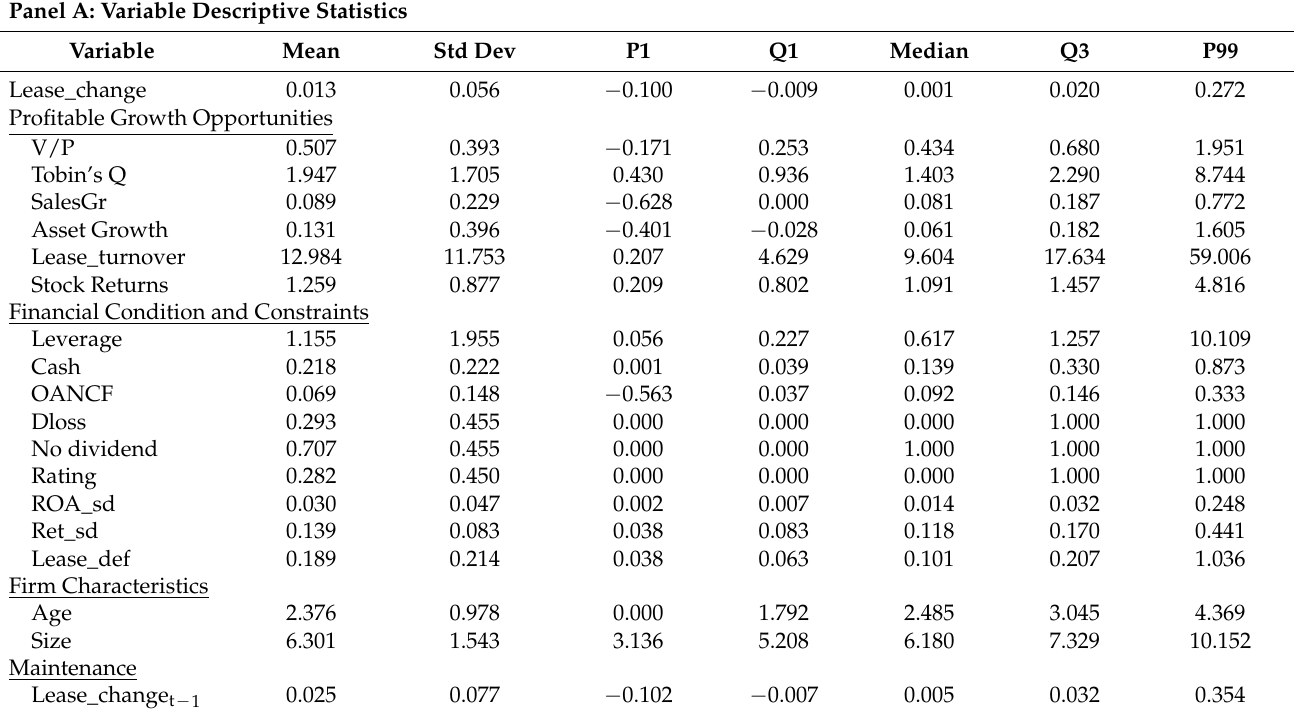
Table 2. Lease Investment